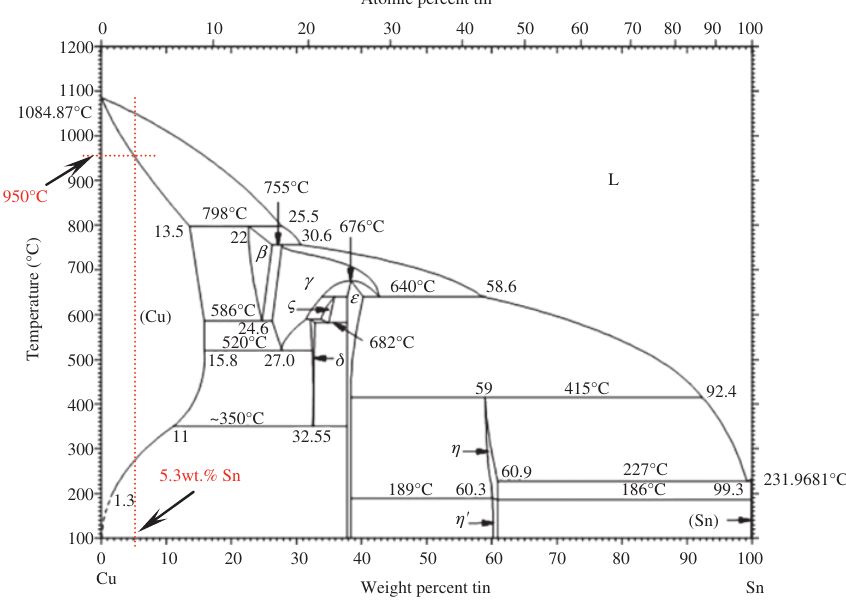
Figure 4 Cu-Sn binary phase diagram